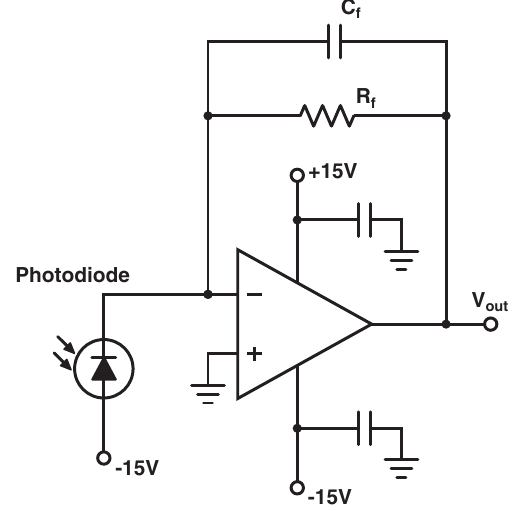
FIG. 3. Photometer circuit for Activity 2. The photodiode students used to detect the room light is visible at the bottom left and is in a reverse-biased configuration. The op-amp portion of the circuit is set up as a transimpedance